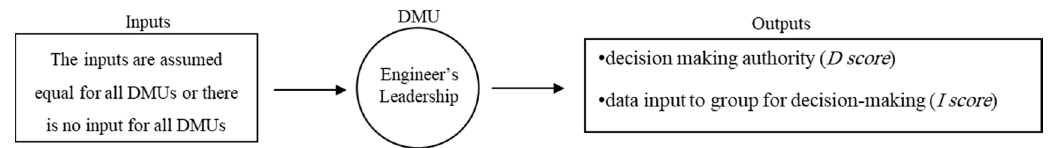
Figure 3. Inputs and outputs of an engineer based on leadership flexibility space.